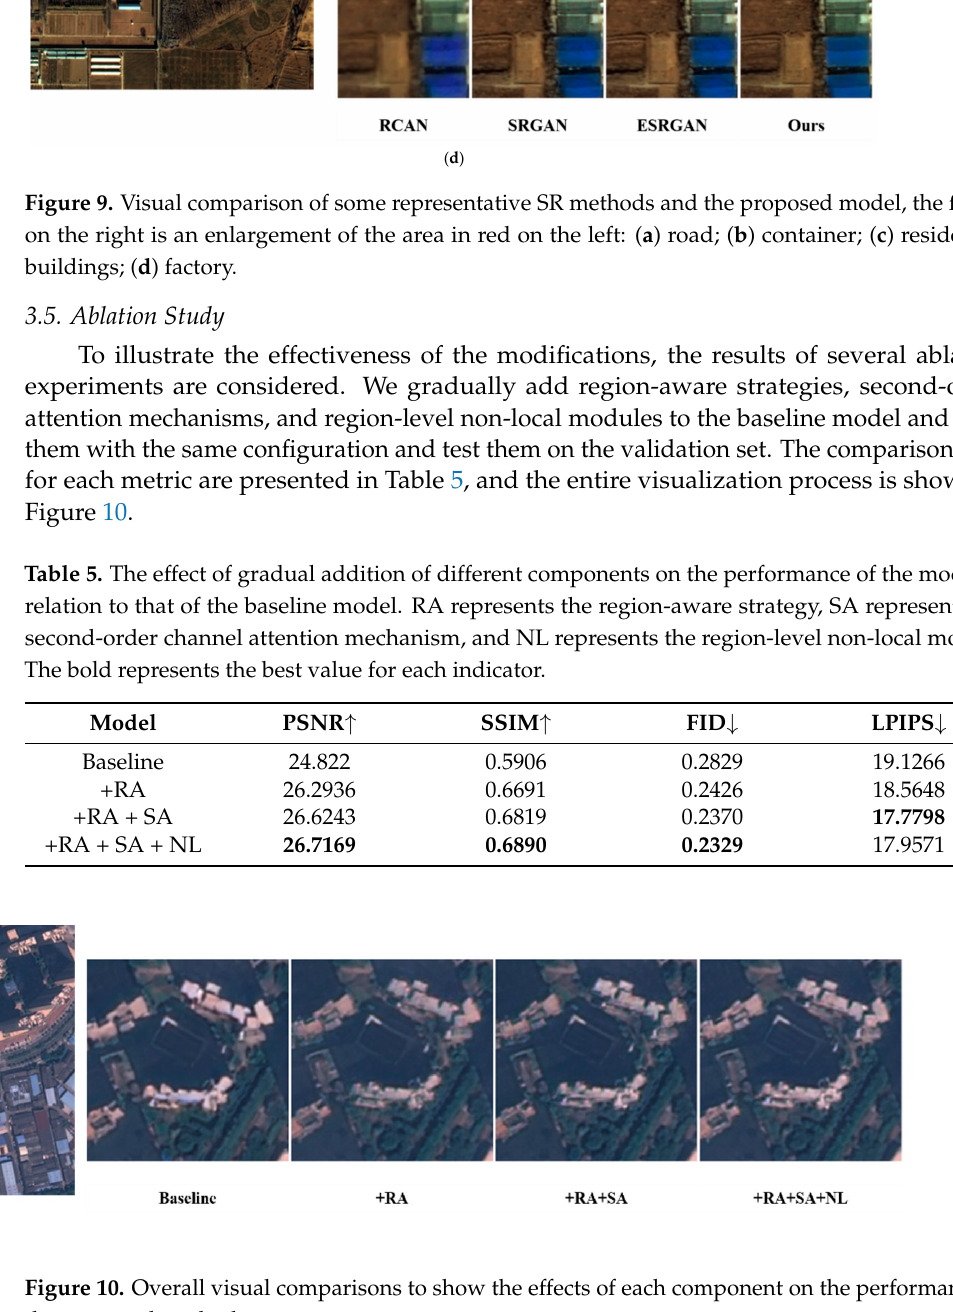
Figure 10. Overall visual comparisons to show the effects of each component on the performance of the proposed method. the proposed